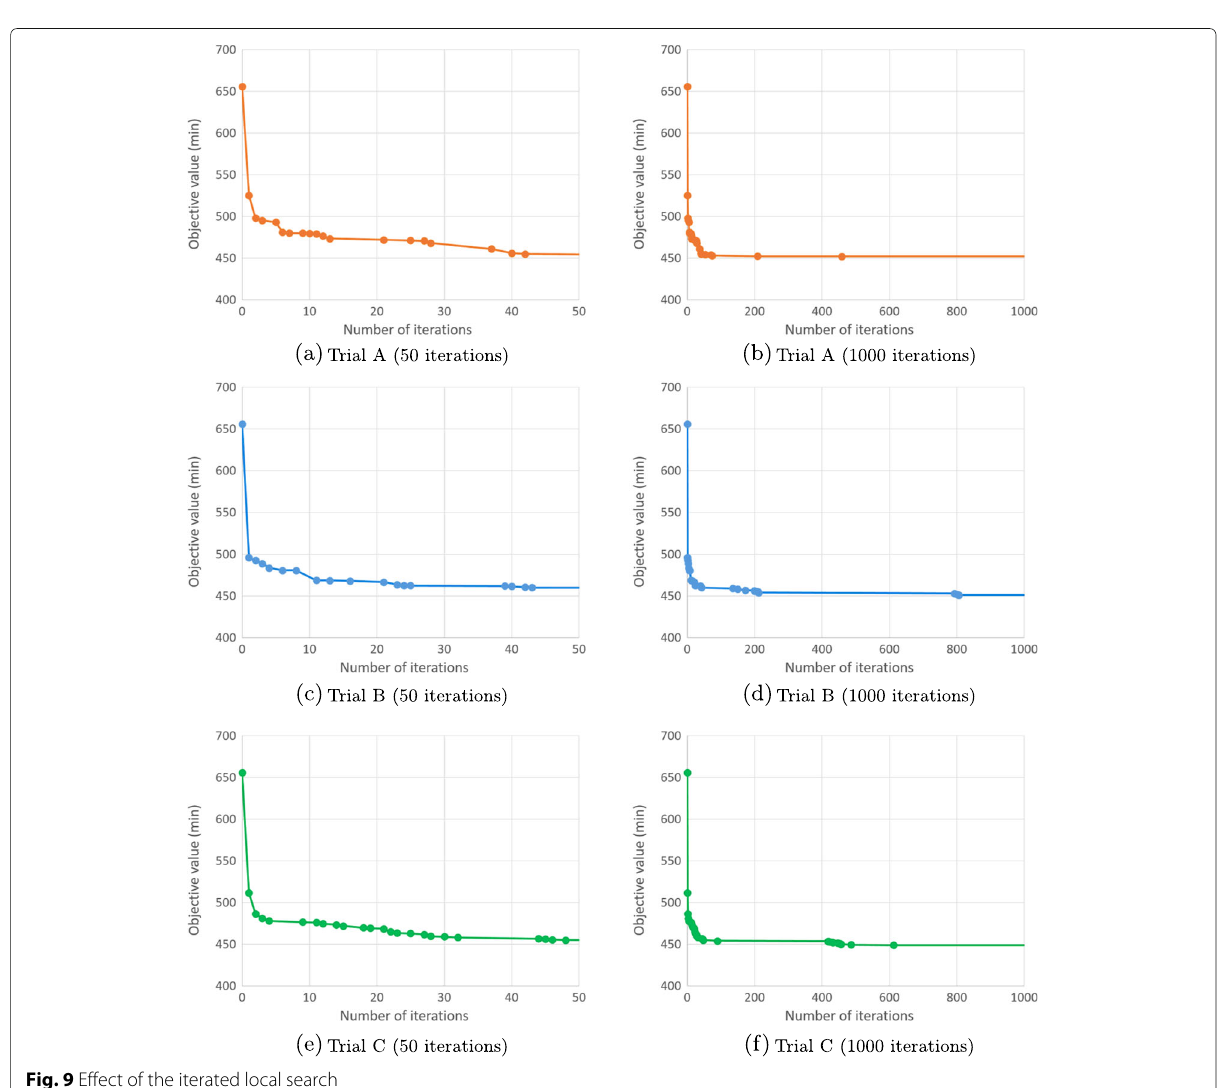
Fig. 9 Effect of the iterated local search